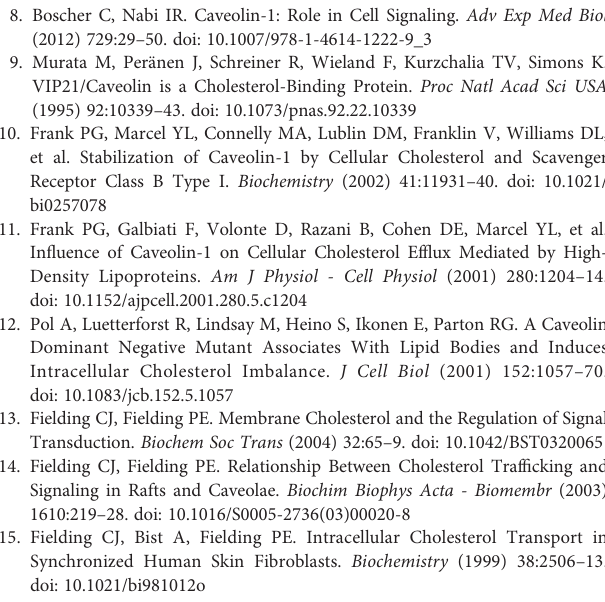
Supplementary Figure 1 | LXR de fi ciency in the liver results in decreased Cav-1 expression in Kupffer cells. Representative confocal images of Cav-1 expression (red) and F4/80 (green) in livers from WT and LXR ab -/- mice. Higher magni fi cation of the insets is shown in the right panels. Scalebar: 20µm. Supplementary Figure 2 | Cellular cholesterol redistribution upon LXR activation correlates with Cav-1 localization in peritoneal macrophages. Representative images showing the subcellular distribution of Cav-1 (green) and Fillipin (blue) in peritoneal macrophages isolated from WT and LXR ab -/- mice and treated for 24 h with 1 m M GW3965 and 100 nM LG268 (G+L). Scalebar: 10µm. Supplementary Figure 3 | Cav-1 and ABCA1 localization in caveolae-like and intracellular vesicles. Representative electron microscopy images showing individual immunogold staining of Cav-1 and ABCA1 in peritoneal macrophages isolated from WT and LXR ab -/- mice. Scalebar: 200nm. Supplementary Figure 4 | Cav-1 in fl uences subcellular distribution of ABCA1 Representative images showing immunostaining of ABCA1 (red) by confocal microscopy in peritoneal macrophages from WT and Cav-1 -/- mice treated for 24 h with 1 m M GW3965 and 100 nM LG268 (G+L). Nuclei were stained with DAPI. Experiment was performed 3 independent times. Scalebar: